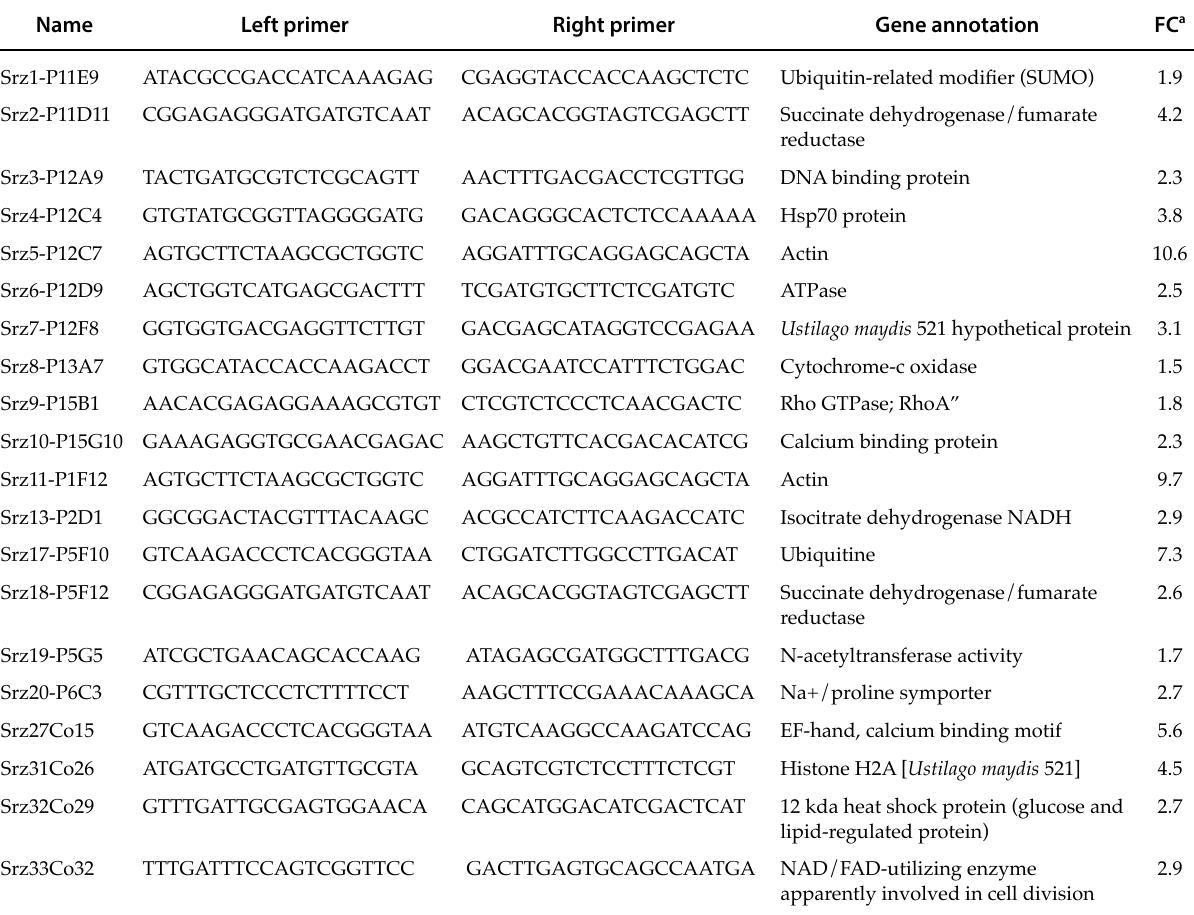
Table 2. Relative expression of candidate genes from cells treated by GR24 during 1h.